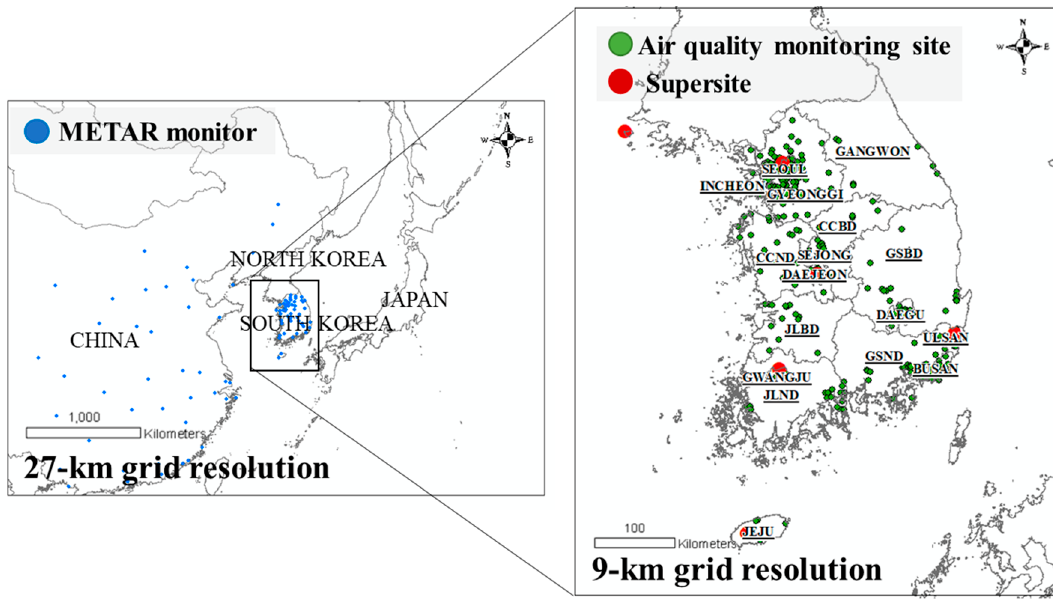
Figure 1. Modeling domains, meteorological stations, and air quality monitoring sites. The 27- and 9-km grid domains have 174 × 128 cells and 67 × 82 cells, respectively. The blue dots represent METeorological Aerodrome Reports (METAR) monitors. The green and red circles depict the urban air quality monitoring sites (AMS) and six supersites, respectively.